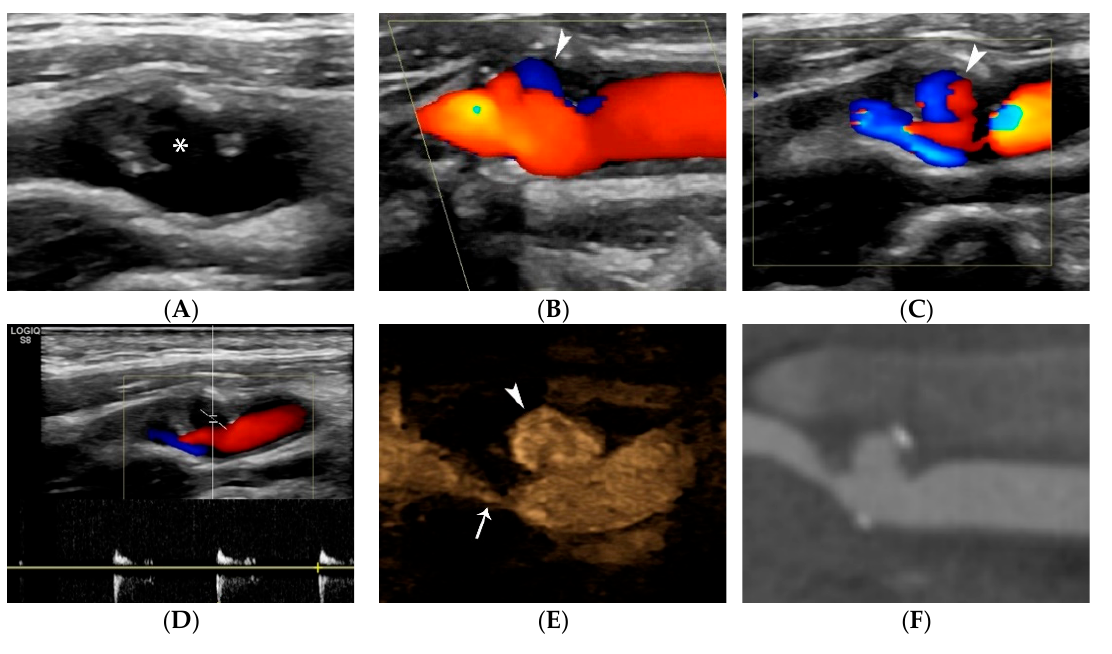
Figure 7. A 57-year-old man undergoing pre-operative carotid ultrasound. B-mode image ( A ) show- ing a severely stenotic internal carotid artery plaque with a large ulceration cavity (asterisk). Colour- Doppler technique images showing the classic ulceration signs of blood flow reversal ( B ) (arrow- head) and “yin-yang” sign ( C ) (arrowhead). Pulsed wave Doppler technique ( D ) showing the “to- and-fro” flow pattern. B-Flow technique ( E ) accurately visualizing full extent of the ulceration (ar- rowhead) and stenotic lumen (arrow), without overwriting, aliasing or Doppler-Dependence arti- fact. The need for echocontrast agent (microbubbles) is obviated. CTA image ( F ) confirming the findings and closely correlating with US.